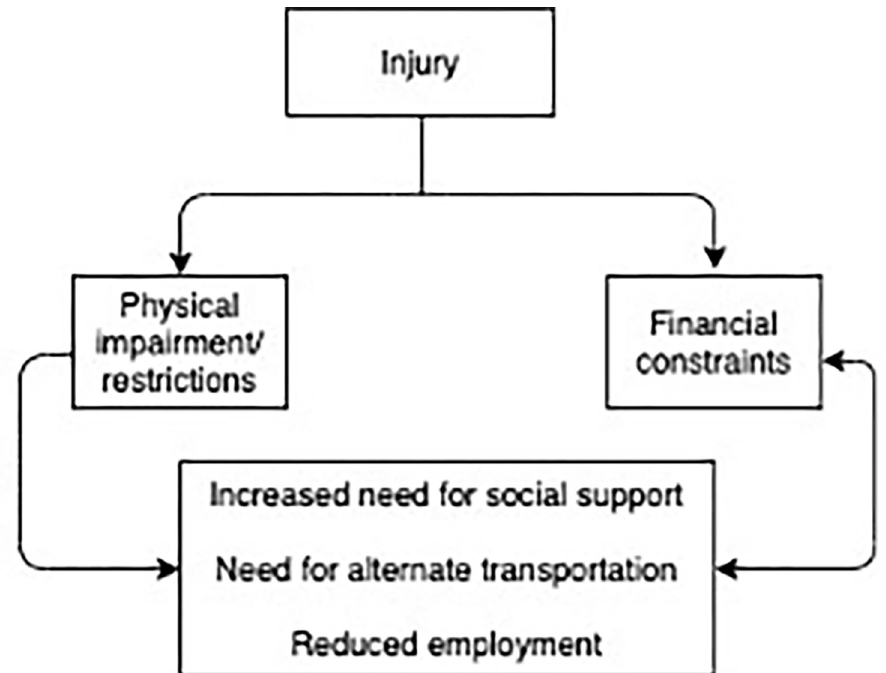
Fig 3. Diagram of transportation barriers in the post-hospitalized injury